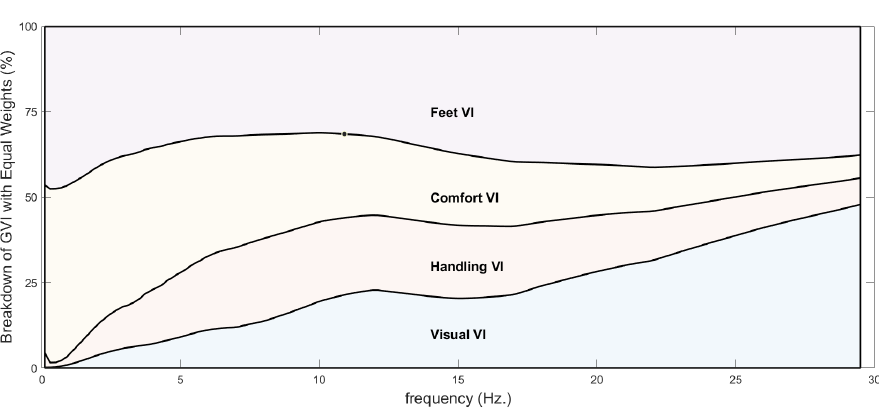
Figure 9. Contribution breakdown of generalized vibration index for equal weights on comfort, handling, visual, and feet vibration